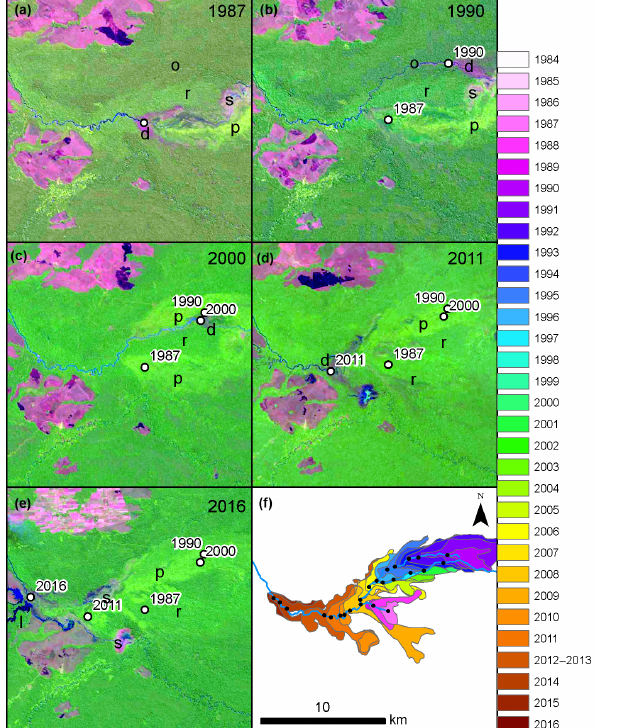
Figure 6. Evolution of the Tequeje River from 1987 to 2016. The river flows from west to east. Inset (a) shows the situation in 1987, when the coverage of cloud-free Landsat imagery began. Lowercase letters indicate land cover: “o” is for old-growth forest, “p” is for pioneer plants, “r” is for recently regrown forest, “d” is for recently dead forest, “s” is for savannah, and “l” is for lakes. Inset (e) shows the most recent image available with the location of the logjam in 2016. Inset (f) shows the location of the logjams on a yearly basis from 1987 to 2015 and the extension of dead forest as a result of the flooding. Logjams formed from 1996 to 1999 and flooded regions are located to the east of the area shown